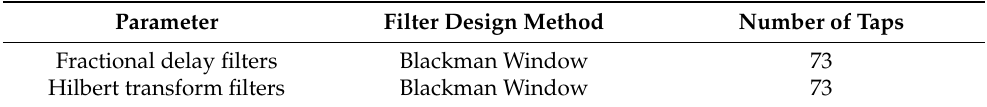
Table 2. Parameters for the Table 1. The mismatches of the TI ‐ ADCs simulation system.